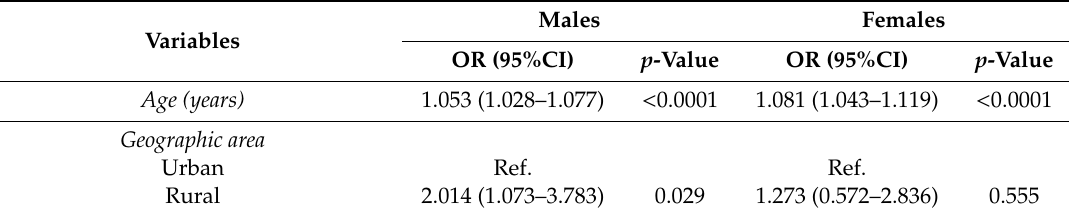
Table 3. Multivariate logistic regression to estimate the risk of gastric cancer.